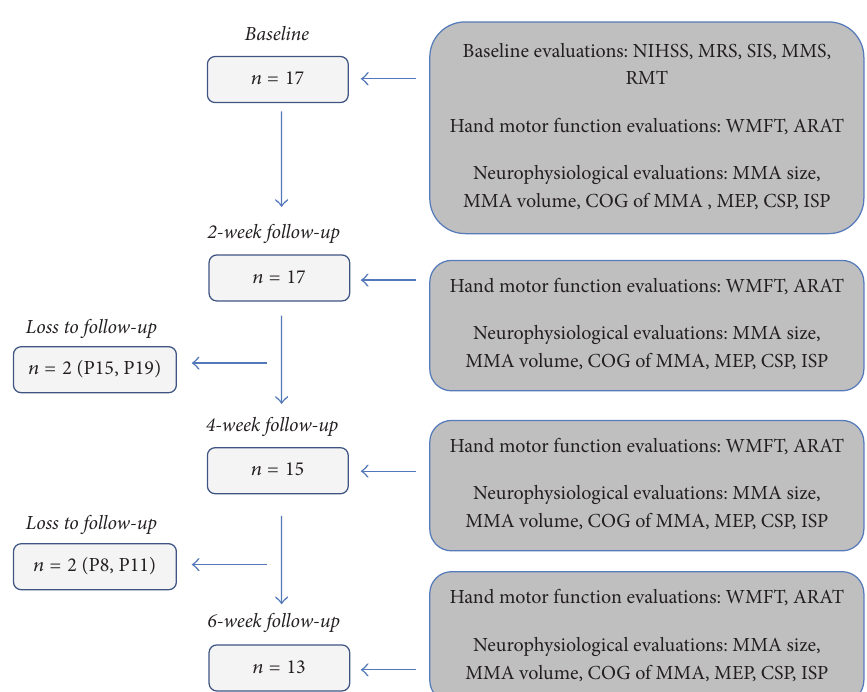
Figure 1: Study design. ARAT = Action Research Arm Test; COG = center of gravity; CSP = cortical silent period; ISP = ipsilateral silent period; MEP = motor evoked potential; MMA = motor map area; MMS = Mini Mental Status Examination Score; MRS = Modified Rankin Scale; NIHSS = National Institute of Health Stroke Scale; RMT = resting motor threshold; SIS = Sensibility Impairment Score; WMFT = Wolf Motor Function